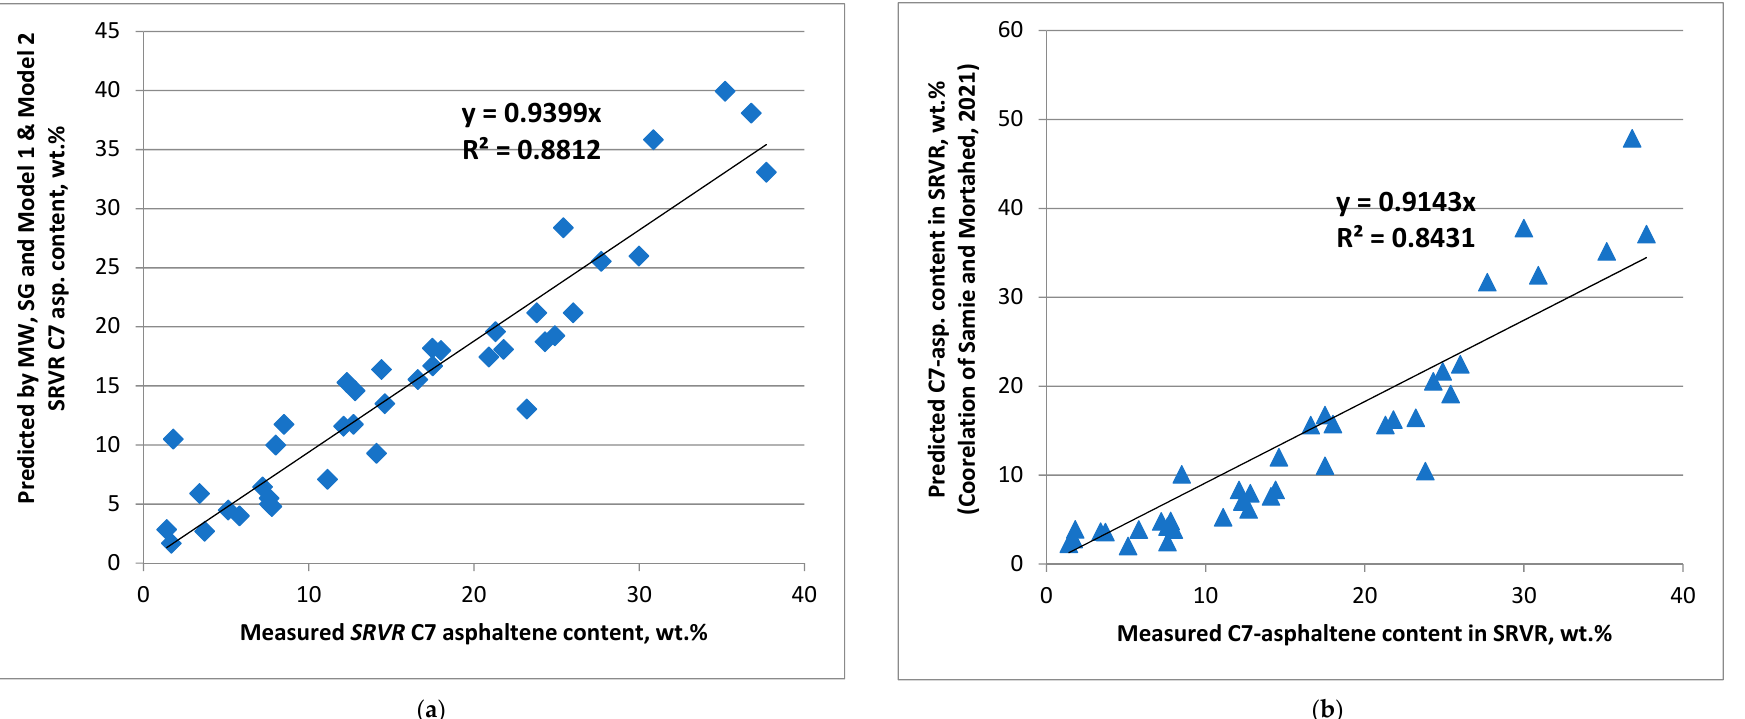
Figure 2. Agreement between measured data and that predicted by MW, SG , and Model 1 and Model 2 for C 7 -asphaltene content in SRVR s ( a ) and by the correlation of Samie and Mortaheb [37] ( b ).